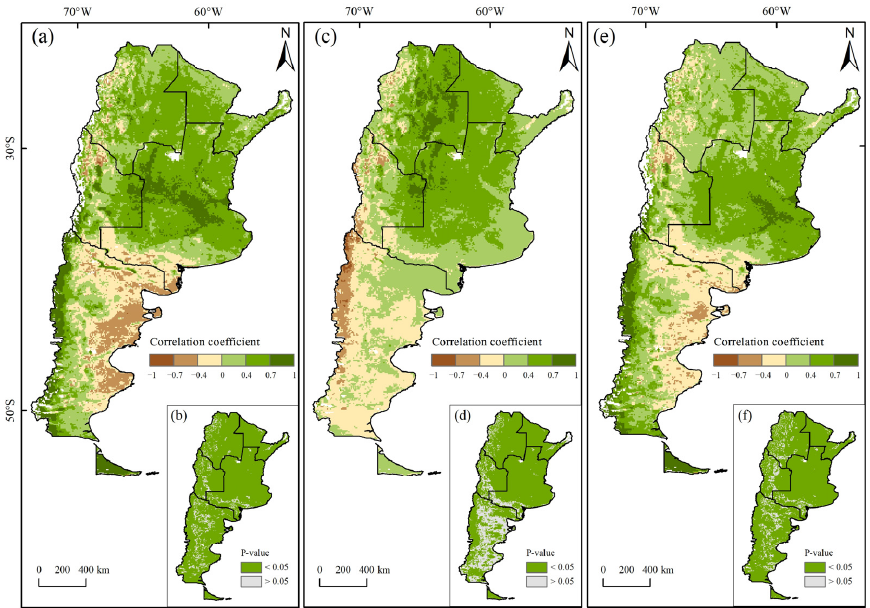
Figure 6. ( a ) Correlation coe ffi cient and ( b ) signi fi cance test of the NDVI and temperature in Argen- tina from 1982 to 2015. ( c ) Correlation coe ffi cient and ( d ) signi fi cance test of the NDVI and precipi- tation in Argentina from 1982 to 2015. ( e ) Correlation coe ffi cient and ( f ) signi fi cance test of the NDVI and solar radiation in Argentina from 1982 to